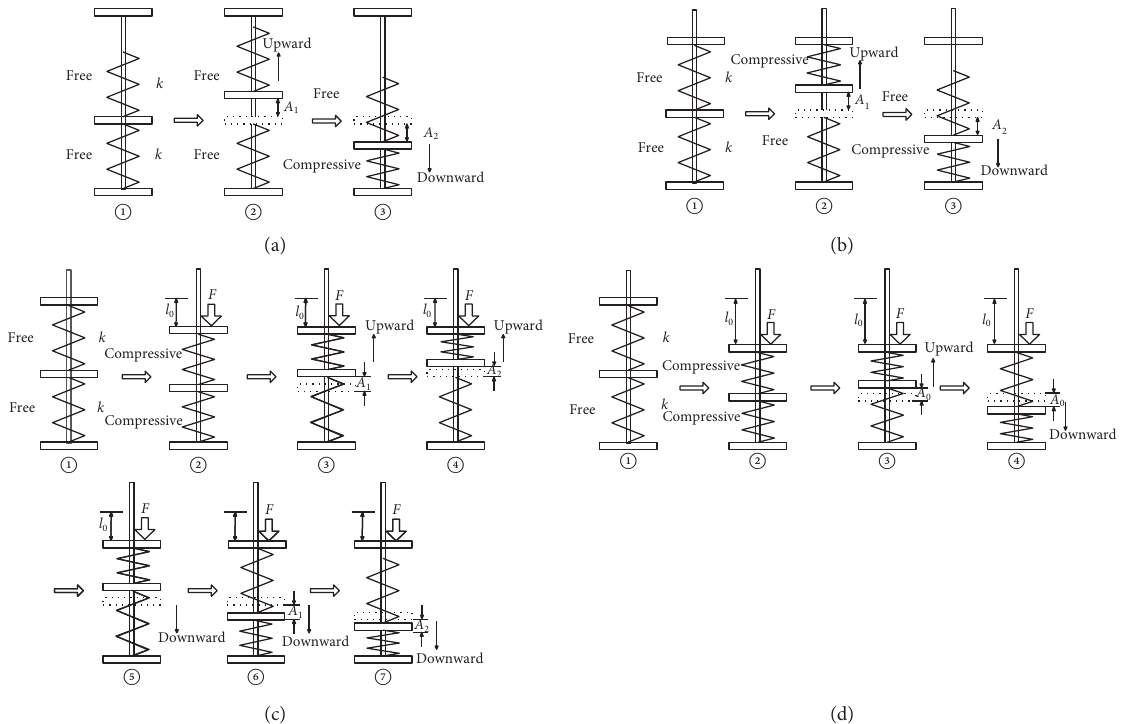
Figure 3: Movements of the disc spring system under four different constraints: (a) no locking and no preloading, (b) locking and no preloading, (c) locking and preloading ( l